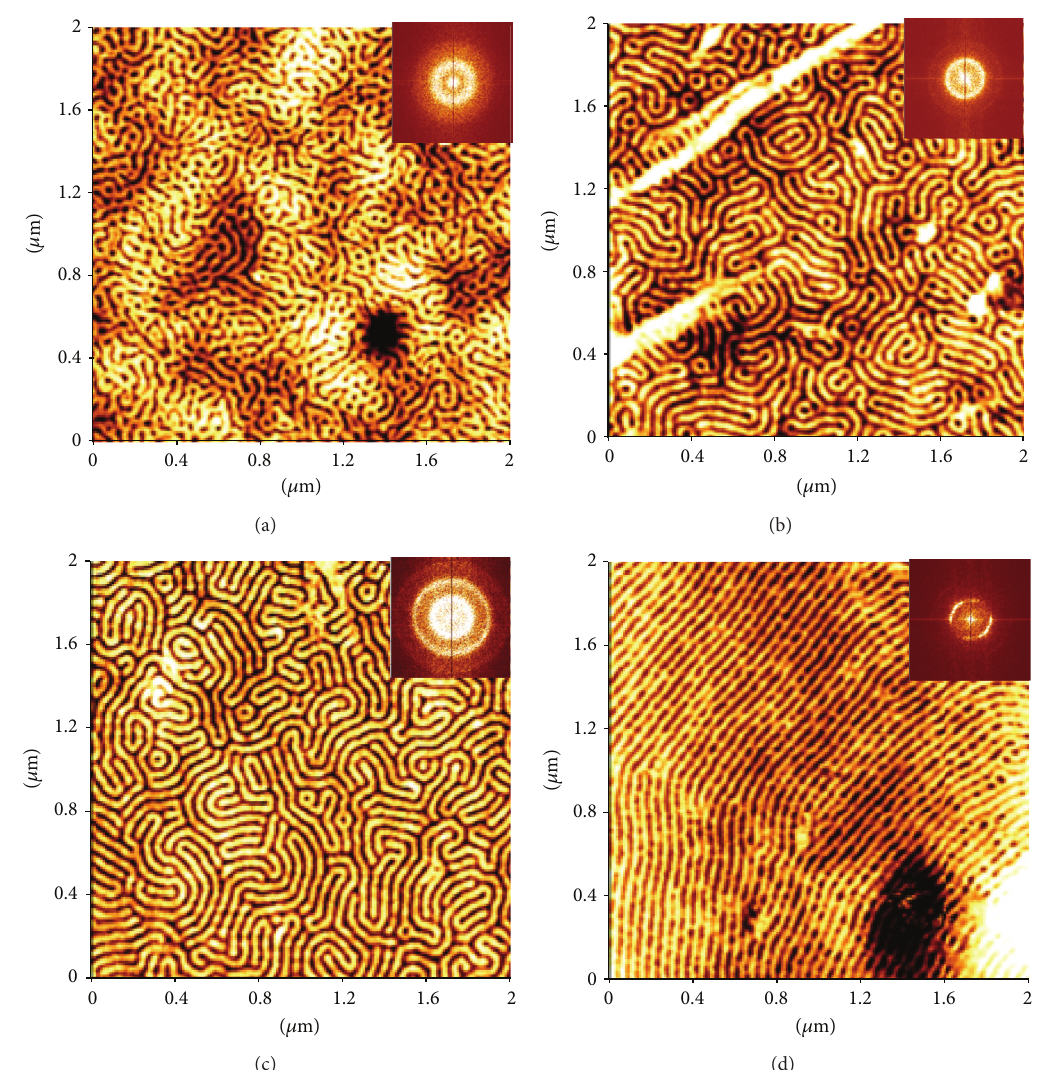
Figure 3: AFM topography images of PS- b -PFS thin films on Si substrates prepared from 1.0 wt.% solution of the polymer in toluene after exposure to a THF for (a) 15min, (b) 30 min, (c) 45 min, and (d) 1 h at room